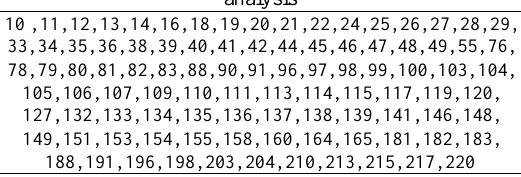
Table (2)- Index of best suitable bands for change map